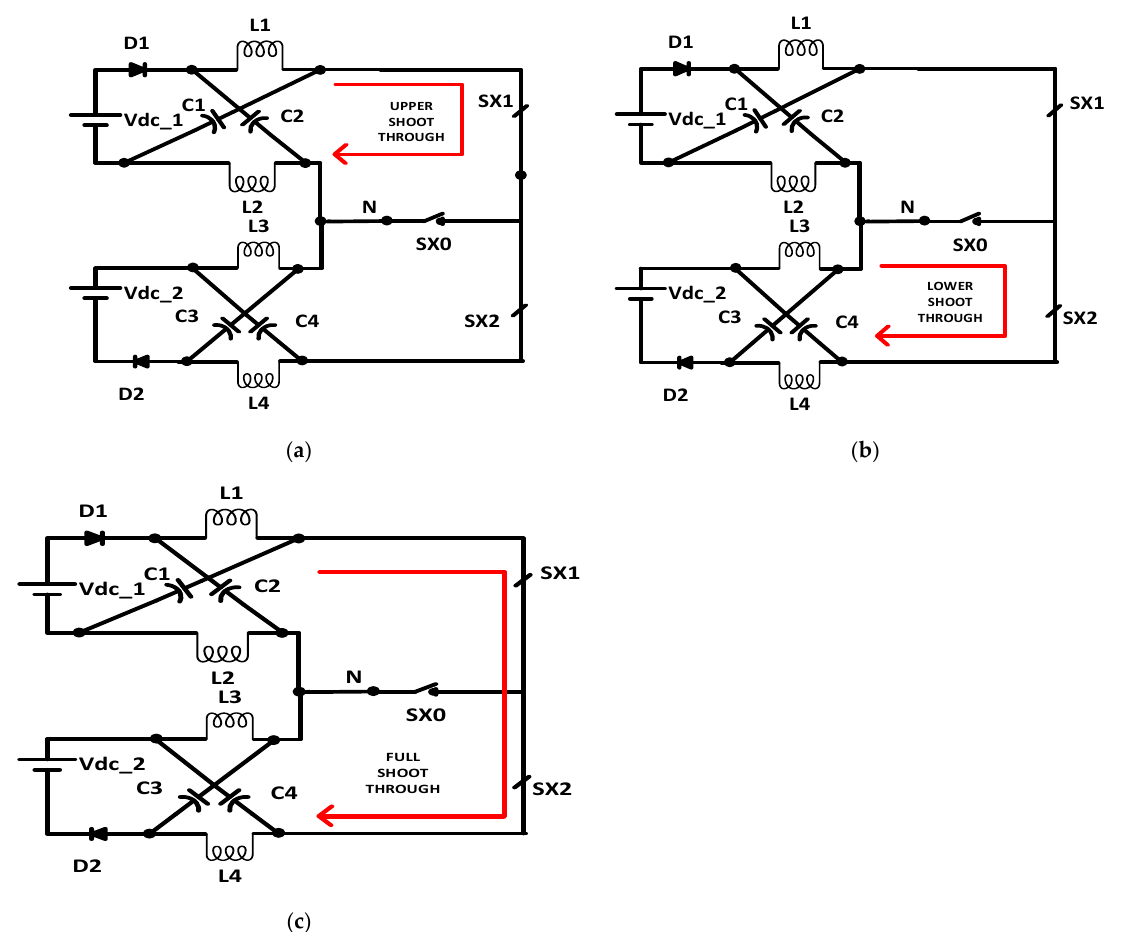
Figure 9. Description of shoot-through states: ( a ) upper shoot-through, ( b ) lower shoot-through, ( c ) full dc-link shoot-through.